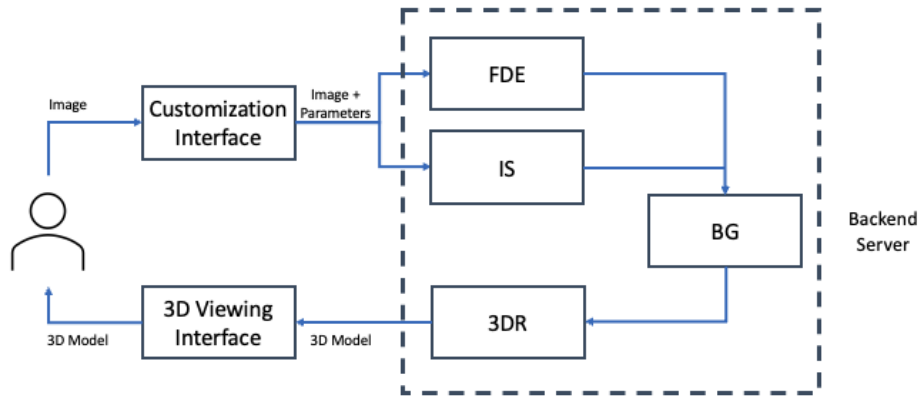
Figure 2. Modular system infrastructure of the TacPic system.